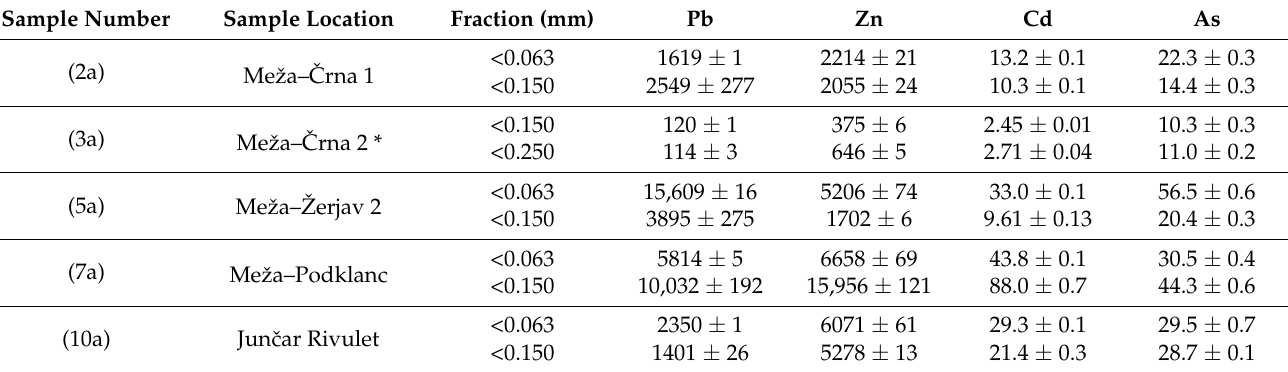
Table 2. Total concentration of Pb, Zn, Cd and As (mg/kg) in two fractions (<0.063 mm and <0.150 mm) of sediment samples from the Meža River and its tributaries determined by ICP-MS. The results are expressed with standard